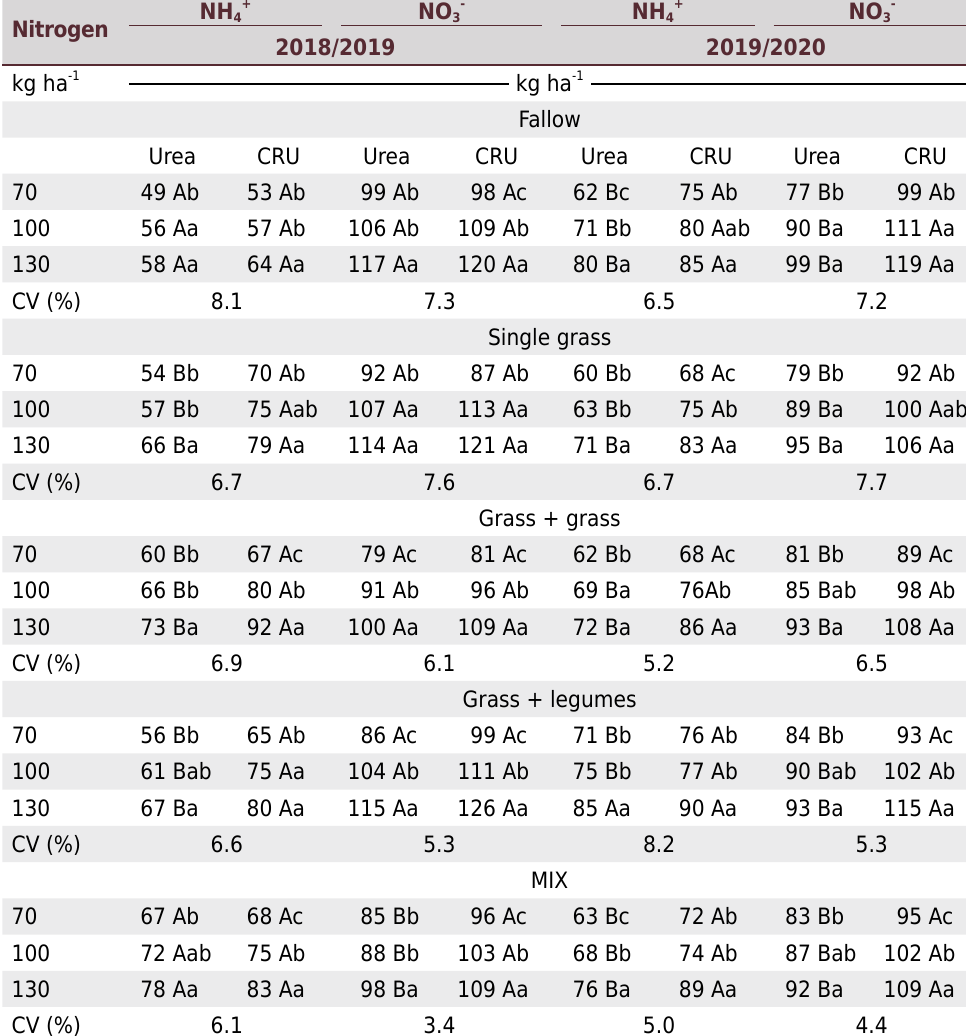
Table 3. Stock of ammonium (NH 4+ ) and nitrate (NO 3- ) of the soil (0.00-0.60 m) after the cotton harvest